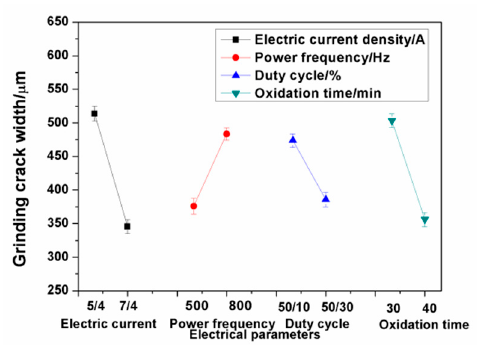
Figure 9. Relationship between the electrical parameters and grinding crack width.